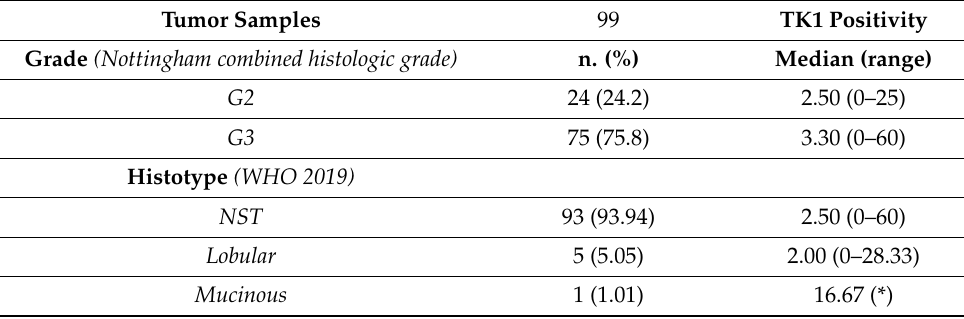
Table 2. Tumor samples’